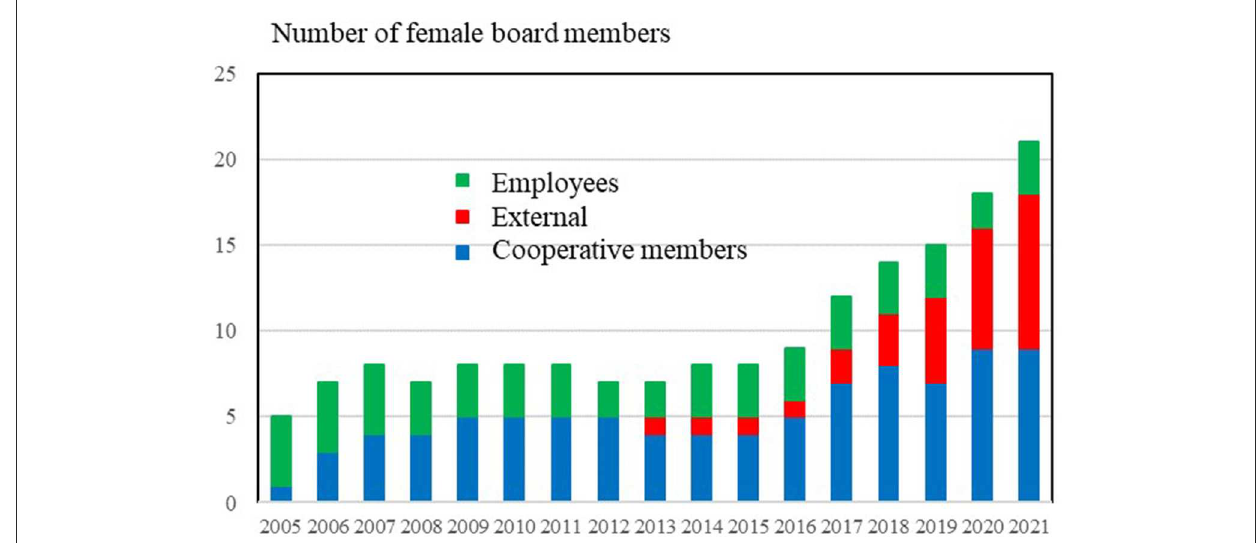
FIGURE5 Groups of female board members of Danish farmer-owned cooperatives, 2005–2021. Source: Own data collection, calculations and presentation based on annual reports and homepages of 25 farmers owned cooperatives in Denmark.